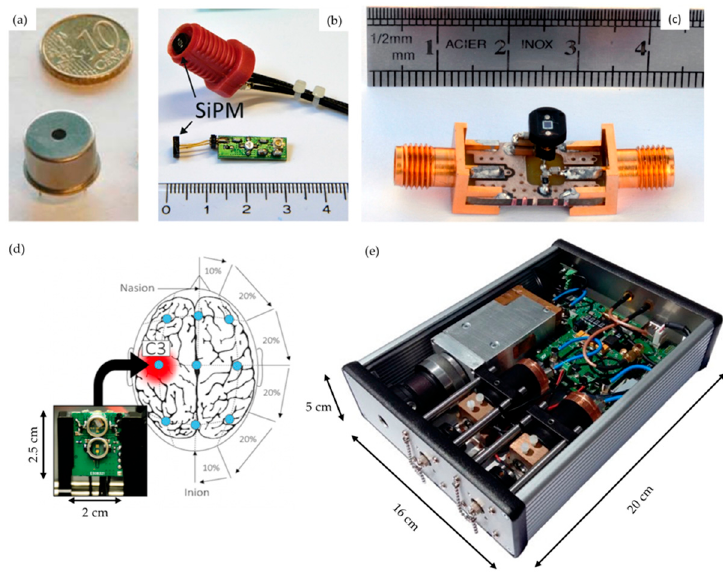
Figure 6. Examples of new TD-NIRS instrumentation. ( a ) Laser diode for compact systems (from [124]). ( b ) A compact probe holder based on a SiPM detector. No optical fibre is needed, and the detector is placed in direct contact with the skin. Extracted from [128]. ( c ) Compact SiPM detector. Extracted from [129]. ( d ) Fibreless TD-NIRS system. Extracted from [130]. ( e ) Compact all-in-one single channel TD-NIRS system. Extracted from